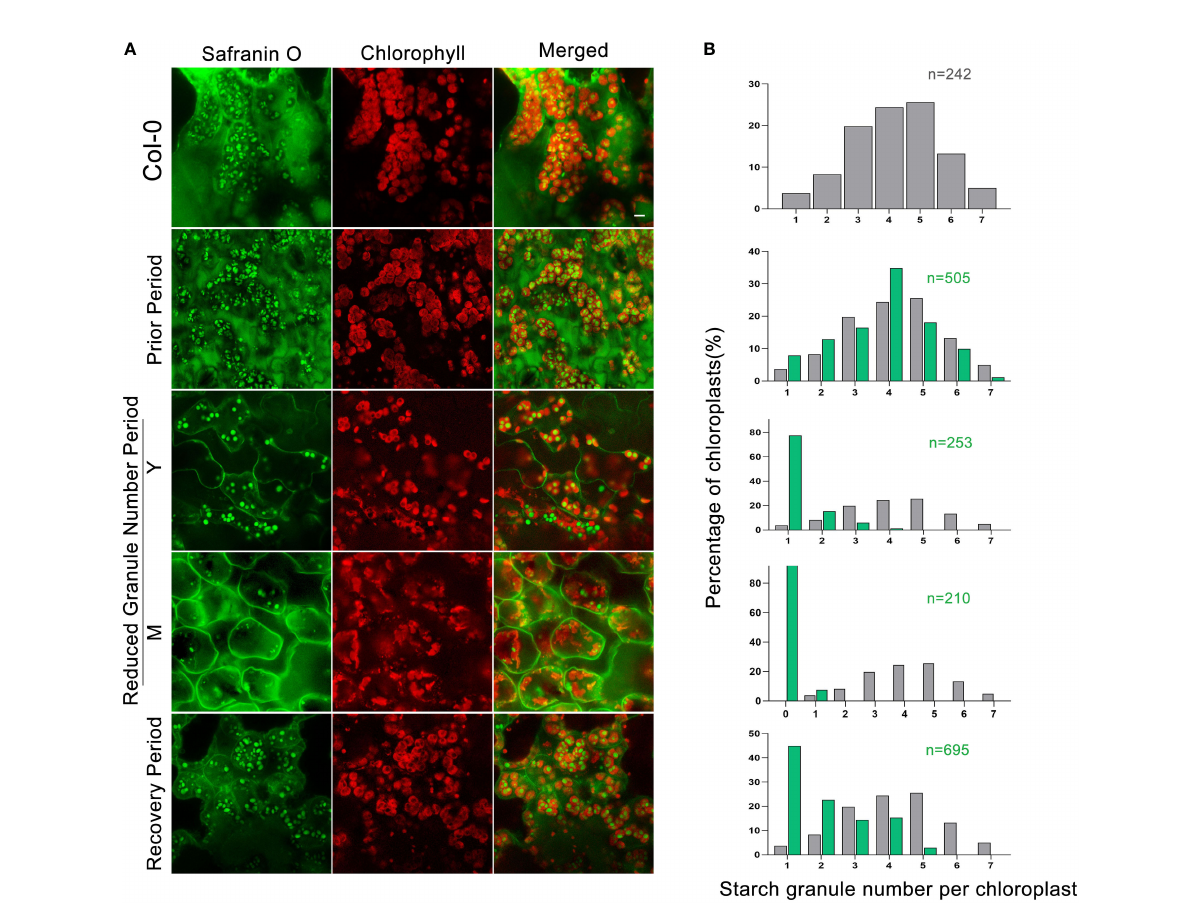
FIGURE 1 LCSM analysis of starch granules in chloroplasts in three periods: (A) Leaves of Col-0 taken from the fi fth week. Prior Period leaves were taken from three-week-old rosettes of dpe2/phs1 . Young (Y) and mature (M) leaves in the Reduced Granule Number Period (RGN) were taken from fi ve-week-old rosettes of the mutant. Recovery Period leaves were taken at the beginning of the sixth week from the mutant. All samples were taken in the middle of the day (6h of light). Scale bar is 5 µm; (B) Quanti fi cation of starch granules per chloroplast. Grey and green colors represent Col-0 and dpe2/phs1 , respectively. N indicates the observed number of chloroplasts. Note: only the granule number distribution of (M) starts with